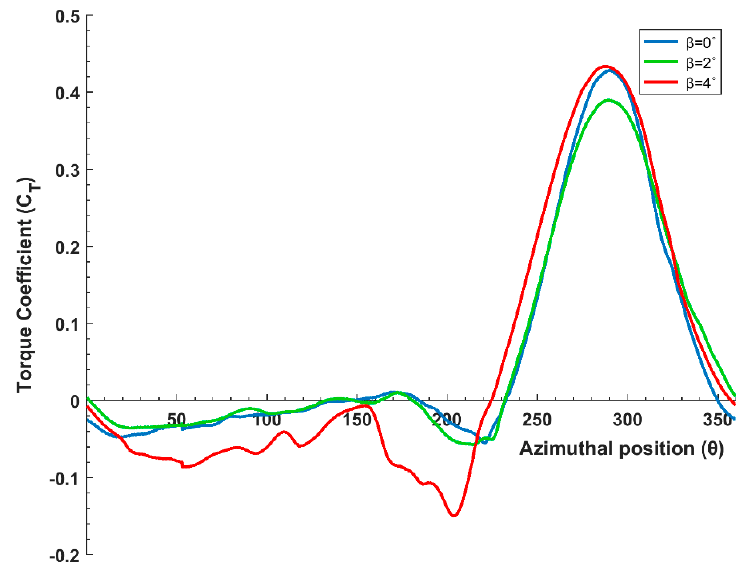
Figure 9. Instantaneous torque coefficient distribution for the Darrieus turbine with R = 0.46 m and TSR = 1.0, for various blade pitch angles ( β ). Energies 2018 , 11 , x FOR PEER REVIEW